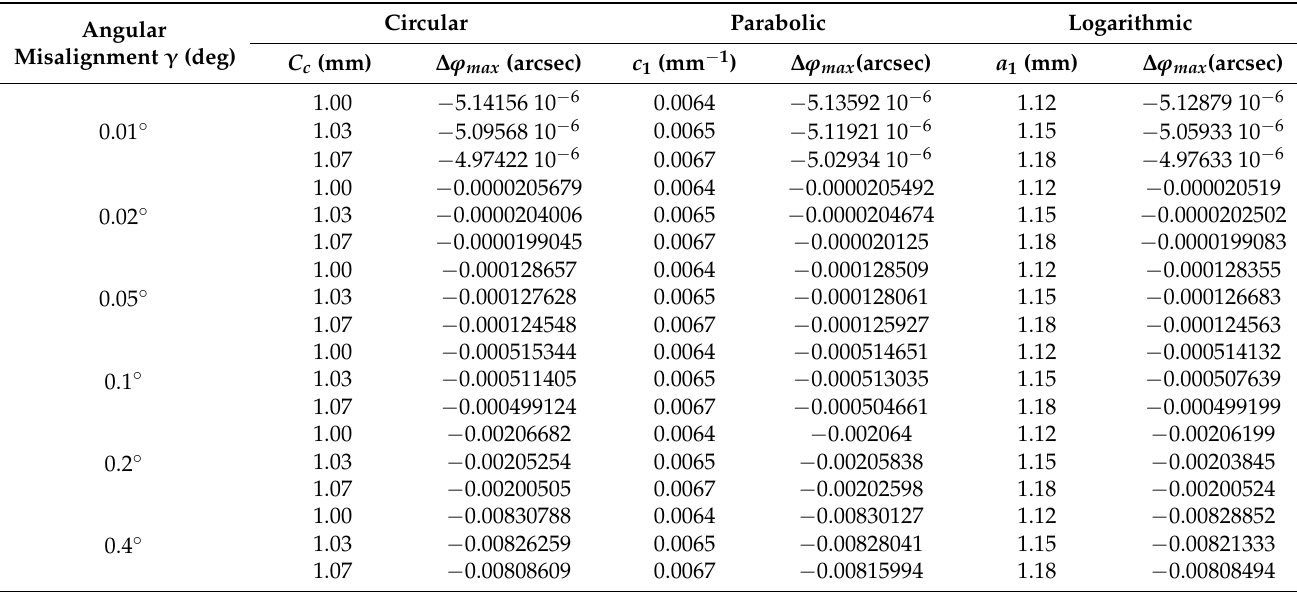
Table 2. Amount of modifications for different values of in-plane angular misalignment error during crowned spur gear meshing.